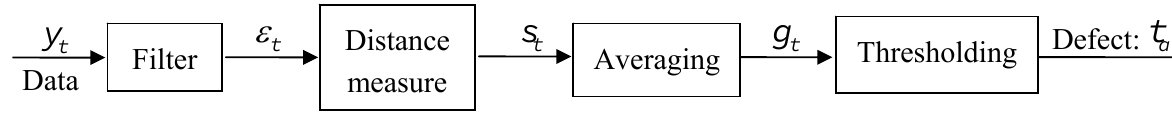
Figure 1. Change detection diagram